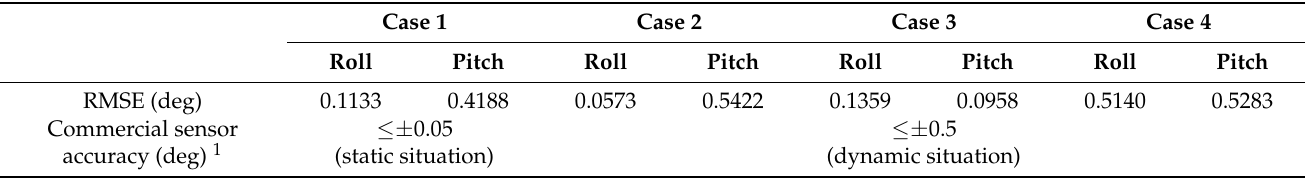
Table 4. Root mean square error (RMSE) calculation results of roll/pitch estimator and accuracy of SST810 datasheet.